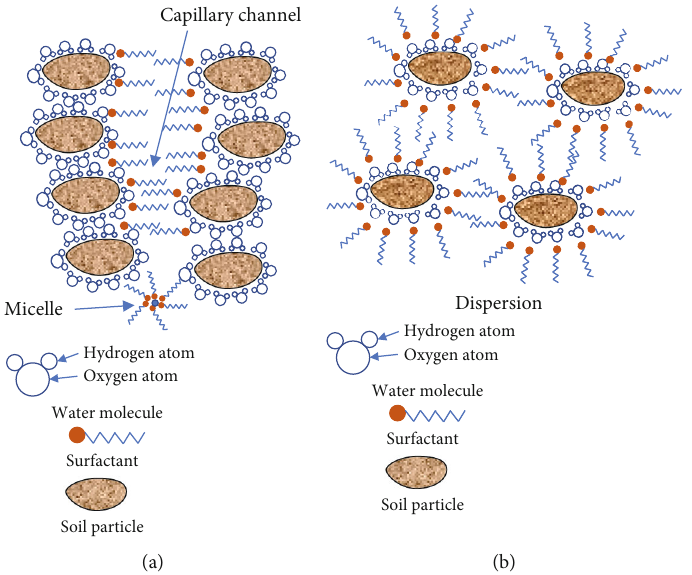
Figure 12: Schematic of the interaction process between anionic surfactant and soil: (a) surfactant molecules in the form of monomer can aggregate into micelles and block some of the capillary channels, thereby reducing the amount of evaporation, and (b) surfactant is adsorbed on the surface of soil particles and enhances soil